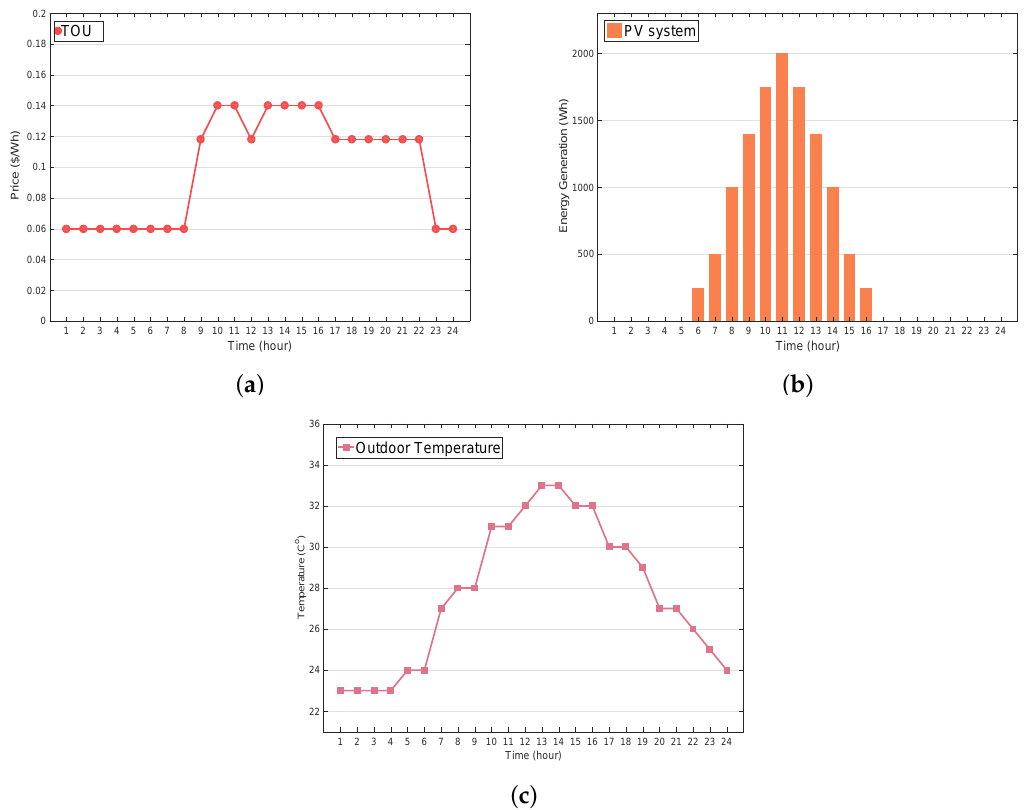
Figure 5. Profiles of electricity price and weather. ( a ) time-of-use (TOU) price; ( b ) solar photovoltaic (PV) generation; ( c ) outdoor